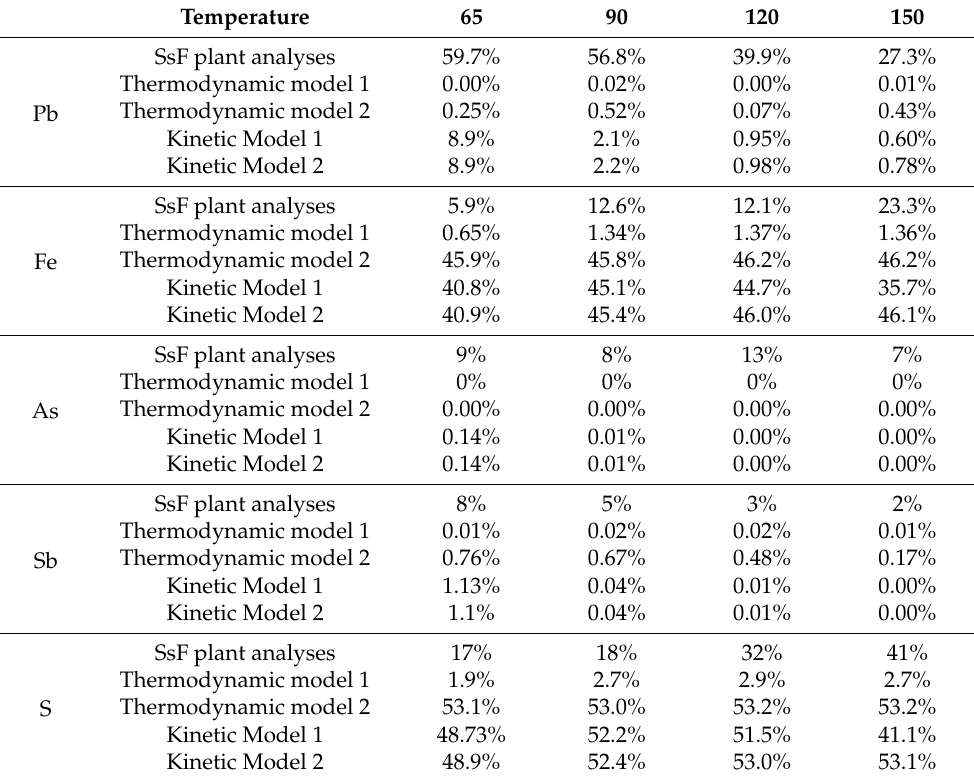
Table 15. Comparison between Soultz-sous-For ê ts, thermodynamic model, and kinetic model results in relative percentage by